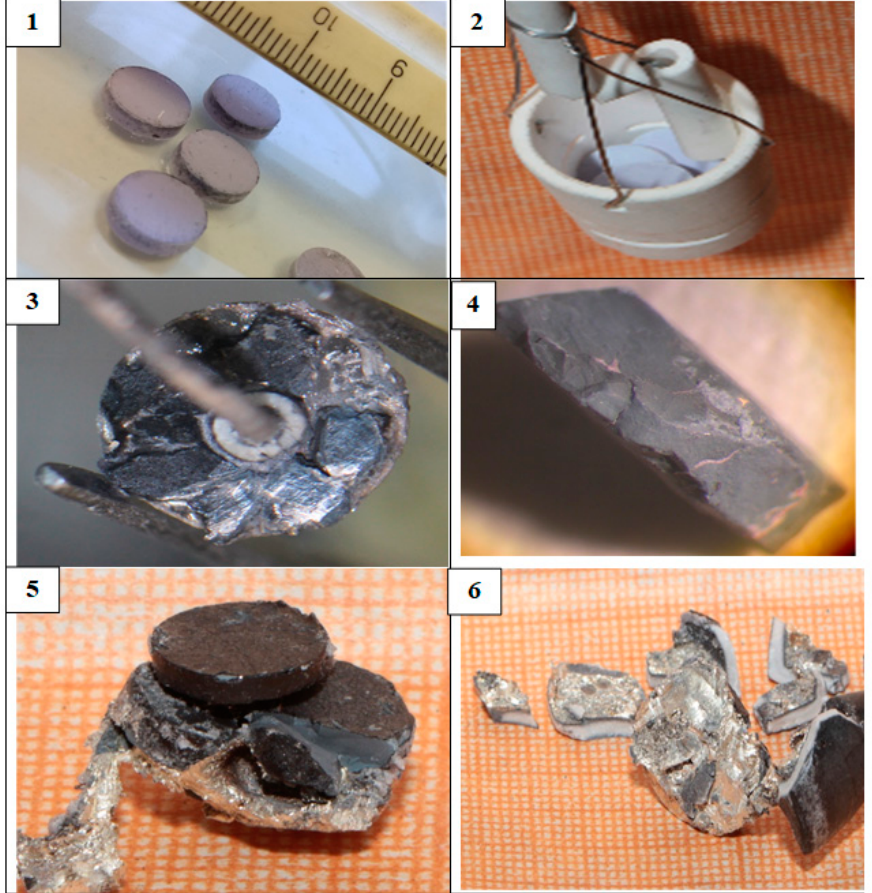
Figure 6. ( 1 ) Pressed and annealed Nd 2 O 3 pellets; ( 2 ) Nd 2 O 3 pellets loaded into the cathode crucible; ( 3 ) mechanically treated fragment of the Nd 2 O 3 pellet on the nickel cathode after the electrolysis; ( 4 ) ethanol-rinsed and dried fragment of the Nd 2 O 3 pellet; ( 5 ) top view of the Nd 2 O 3 pellet after the reduction on the Mo current lead separated from the cathode crucible; ( 6 ) bottom view of the Nd 2 O 3 pellet after the reduction on the Mo current lead separated from the cathode crucible.